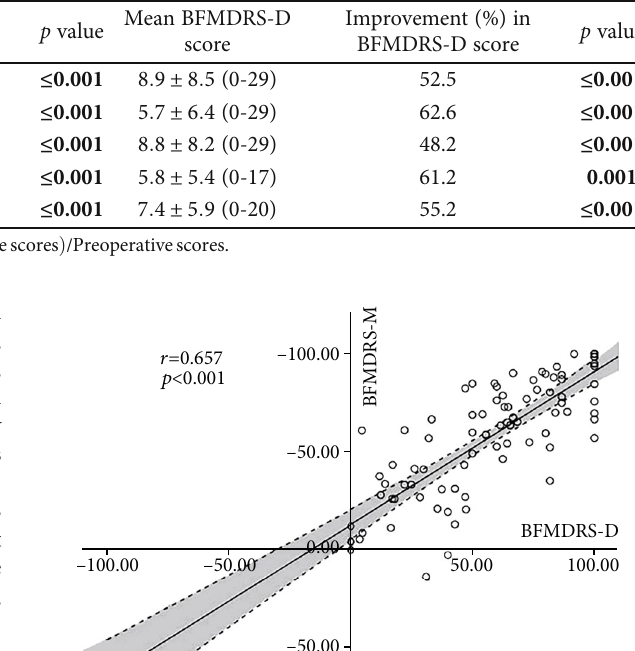
Table 3: Clinical outcomes in di ff erent time categories.